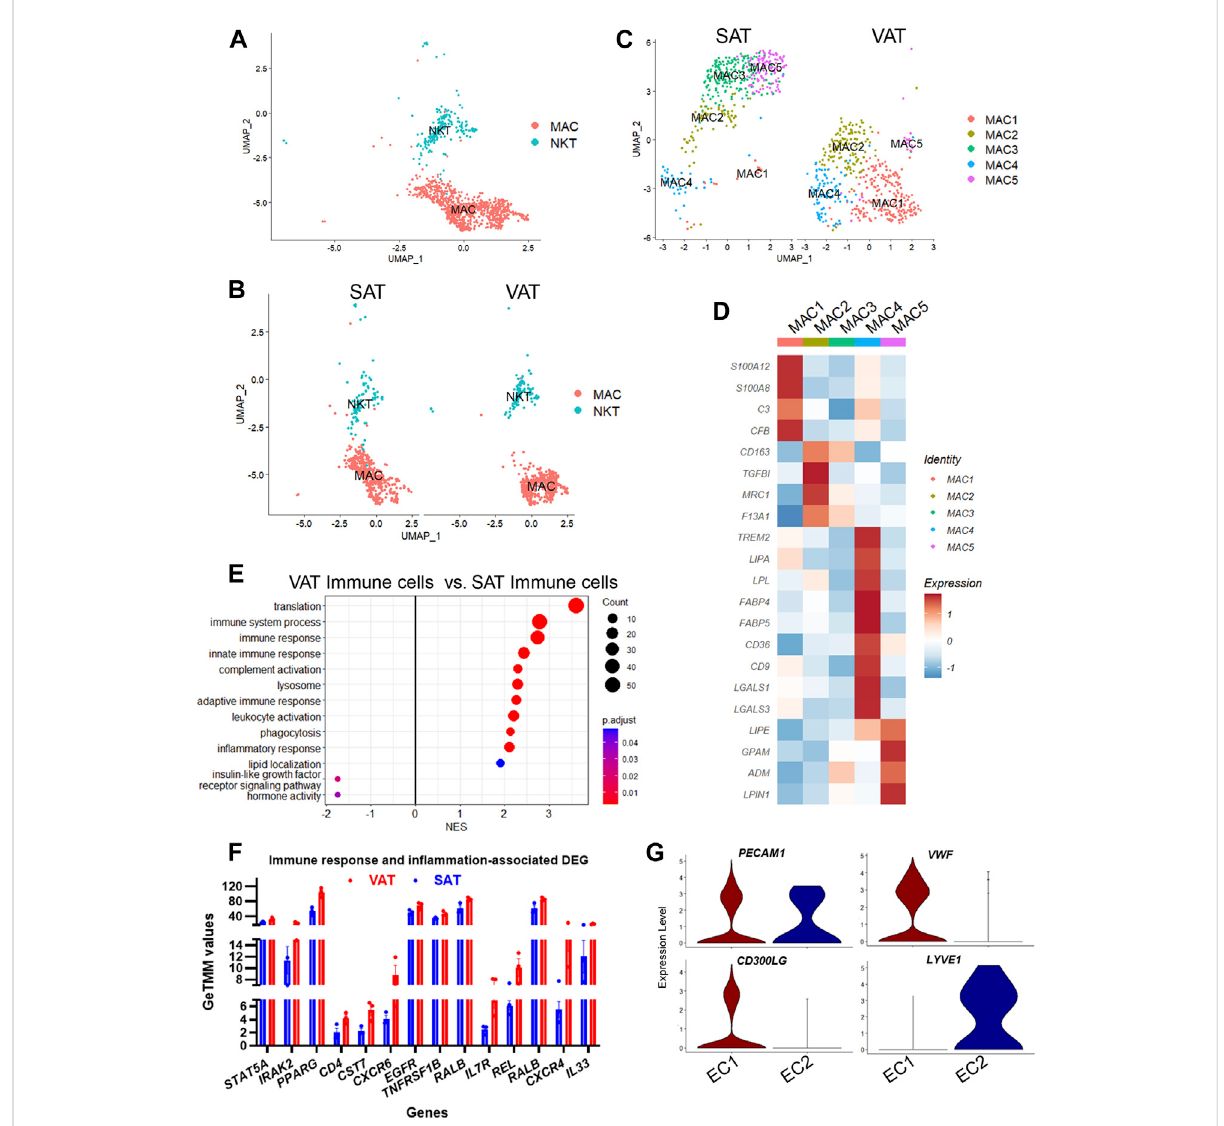
FIGURE 6 Adipose tissue of dairy cows contains distinct subpopulations of immune and endothelial cells. (A) UMAP plot of macrophages/monocytes (MAC)andnaturalkillerandT-cells(NKT)acrossvisceral(VAT)andsubcutaneous(SAT)adiposetissueofdairycows (n=3)obtainedthroughsnRNA- seq analysis. (B) UMAP plots ofVATandSATMAC andNKT subtypes. (C) UMAPplots ofMACsubtypes inSATandVAT. (D) HeatmapofMACsubtypes genemarkersinVATandSAT.Colorencodesthescaledaverageexpressionlevelacrossthosecells(darkredishighandblueislow). (E) Pathway analysis (GSEA) of differentially expressed genes between VAT and SAT immune cells. Positive normalized enrichment score (NES) represents pathway activation on VAT immune cells, while a negative NES represents pathway suppression when compared with SAT immune cells.